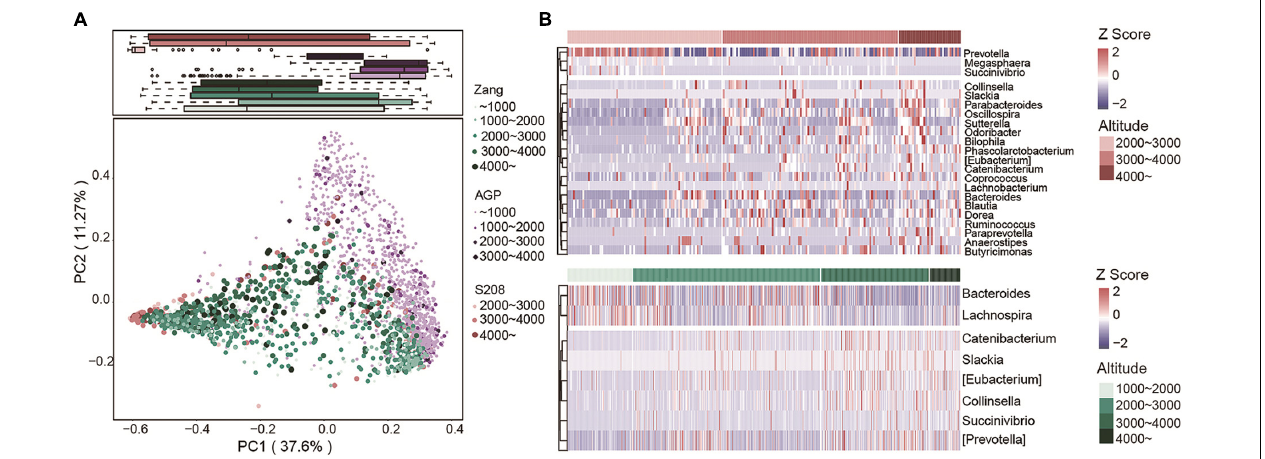
FIGURE 7 | Altitude determines the composition of the gut microbiome in other ethnic groups. (A) PCoA plot based on Bray-Curtis dissimilarity at the genus level from three datasets (Zang, n = 1059; AGP, n = 1244; S208, n = 208), the color and size of dots represent different datasets and altitudes. (B) Relative abundance of genera significantly correlated with altitude at the dataset of S208 (top) and Zang (bottom) by Spearman’s correlation (adjusted P < 0.05). The abundance profiles are transformed into Z -score, negative Z -score represents lower abundance than mean and a positive Z -score represents higher abundance than